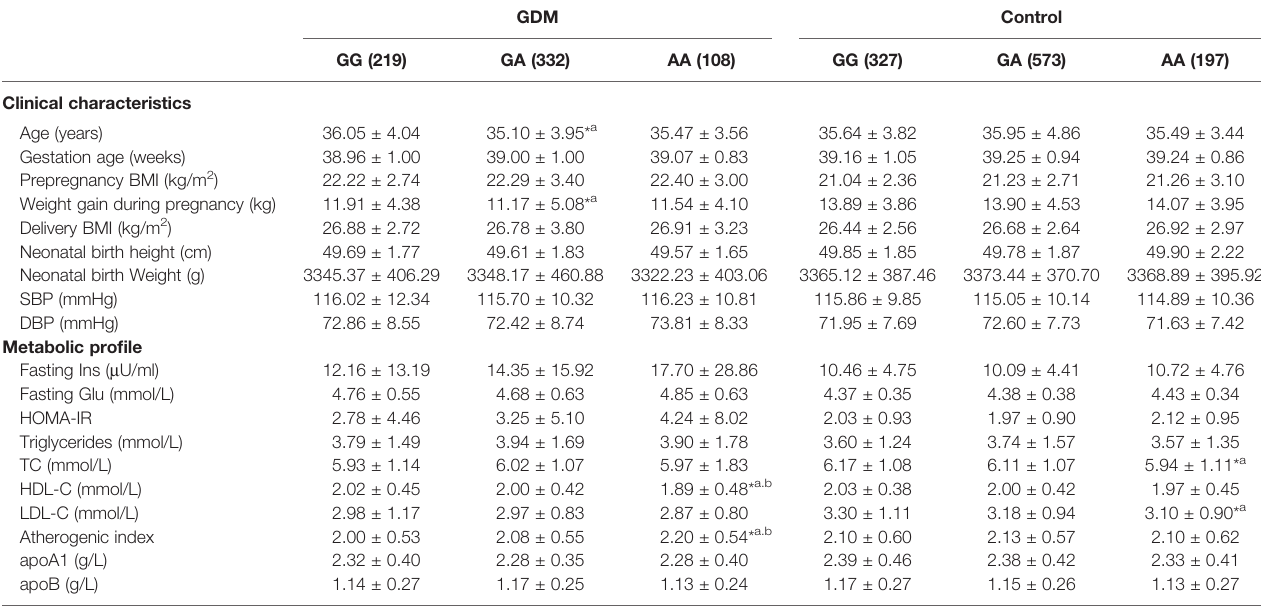
TABLE 4 | Clinical characteristics and metabolic pro fi le of ABCA1 rs2230806 genotypes in GDM patients and controls.